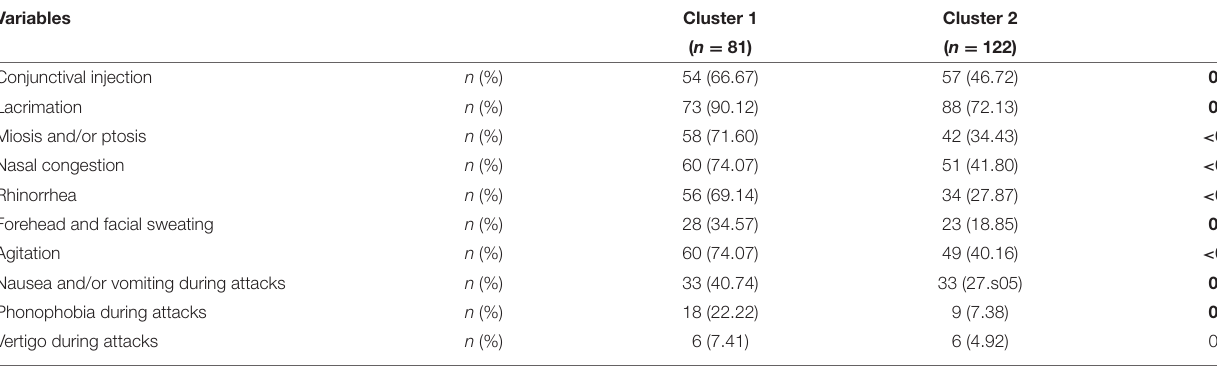
TABLE 2 | Associated symptoms or signs, ipsilateral to the headache, which were reported by the patients in cluster analysis.